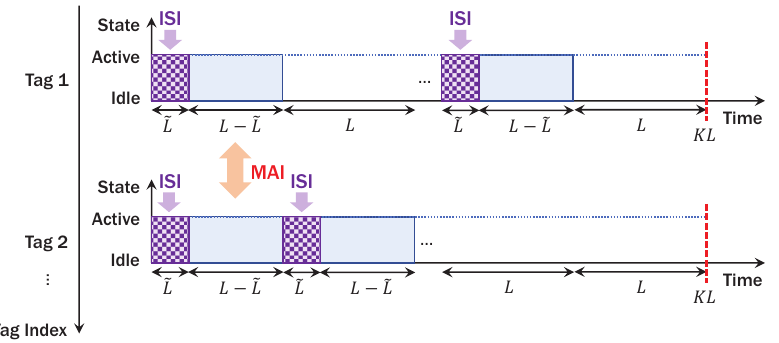
Figure 3. Example of duty-cycling operation per codeword of length (cid:101) K = KL